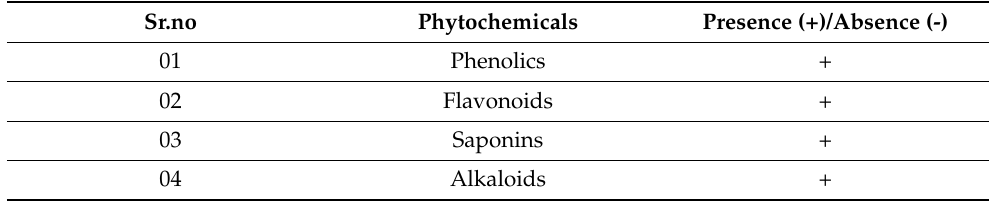
Table 2. Phytochemicals present in Cleome brachycarpa aqueous